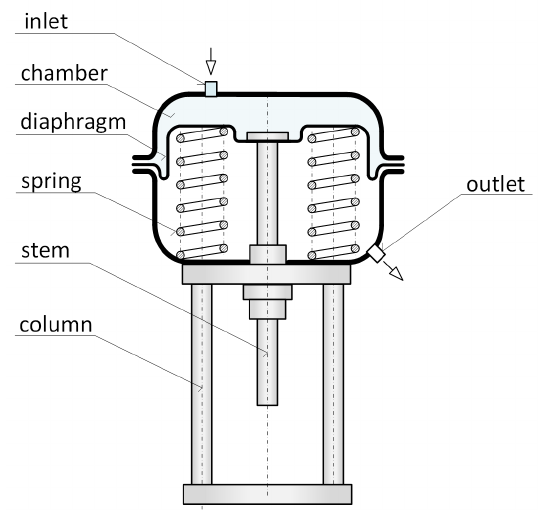
Figure 3. Simplified cross–sections of single- and normal-action (air-to-close) multi-spring and diaphragm pneumatic